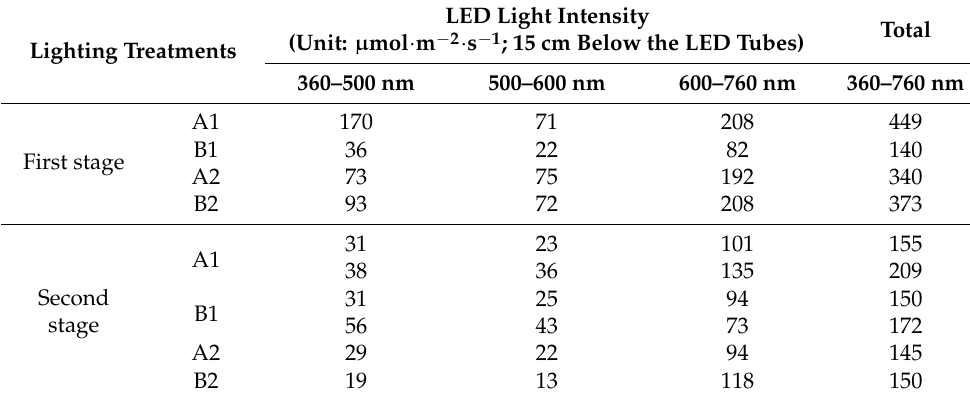
Table 1. Light quantum value of each light band of the LED.